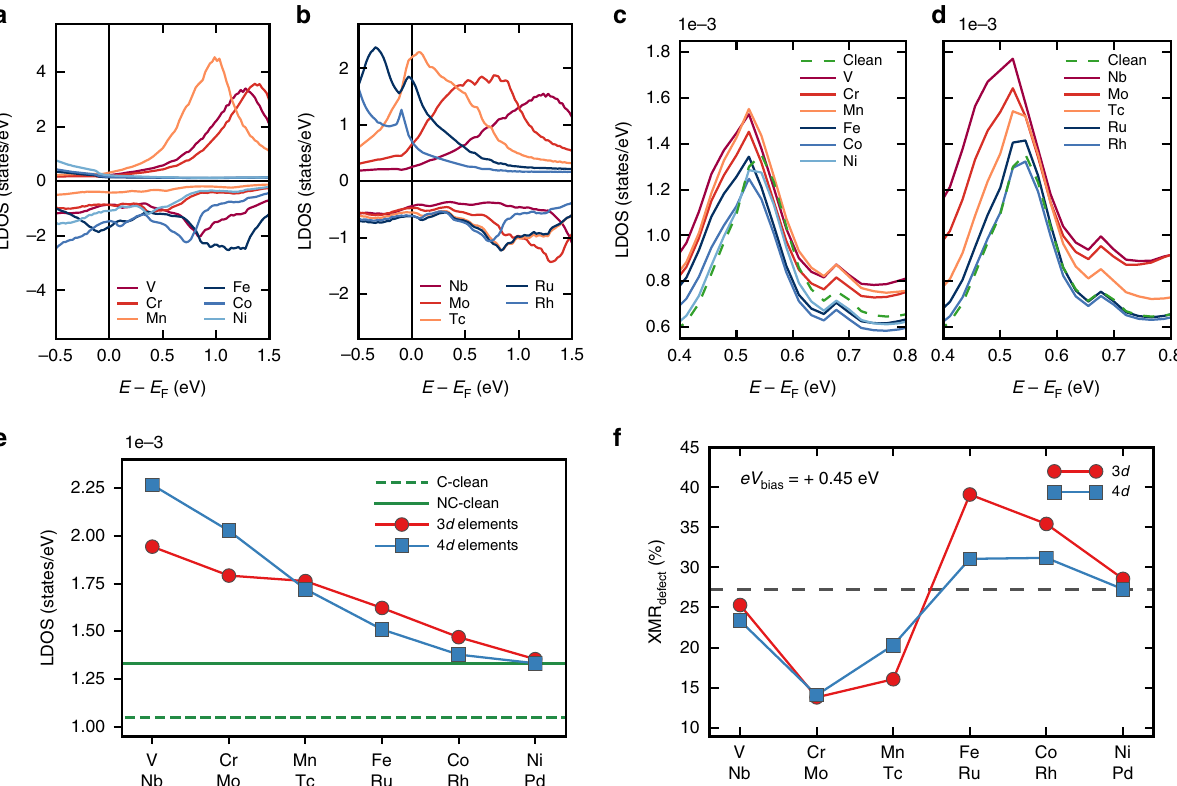
Fig. 3 Impact of defects on the electronic structure and on the XMR defect signal. Local density of states (LDOS) of the defect within the collinear con fi guration for a the 3 d -inatom series b the 4 d -inatom series. The minority-spin channels of the LDOS of the vacuum on top of the core of the skyrmion with a c 3 d and d 4 d impurity close to the skyrmion core. e Chemical trend of the total LDOS of the vacuum on top of the core of the skyrmion at + 0.45 eV for the 3 d -elements (red line) 4 d -elements (blue line), where the total LDOS is the sum of the LDOS of the minority- and majority-spin states. The green full line (dashed line) indicates the LDOS of the vacuum within the non-collinear (collinear) magnetic region for the defect free-system substrate at + 0.45 eV. f Impact of band- fi lling on the defect spin-mixing magnetoresistance (XMR defect ) at an injection energy eV bias = 0.45 eV. The gray dashed line indicates the signal of the XMR clean